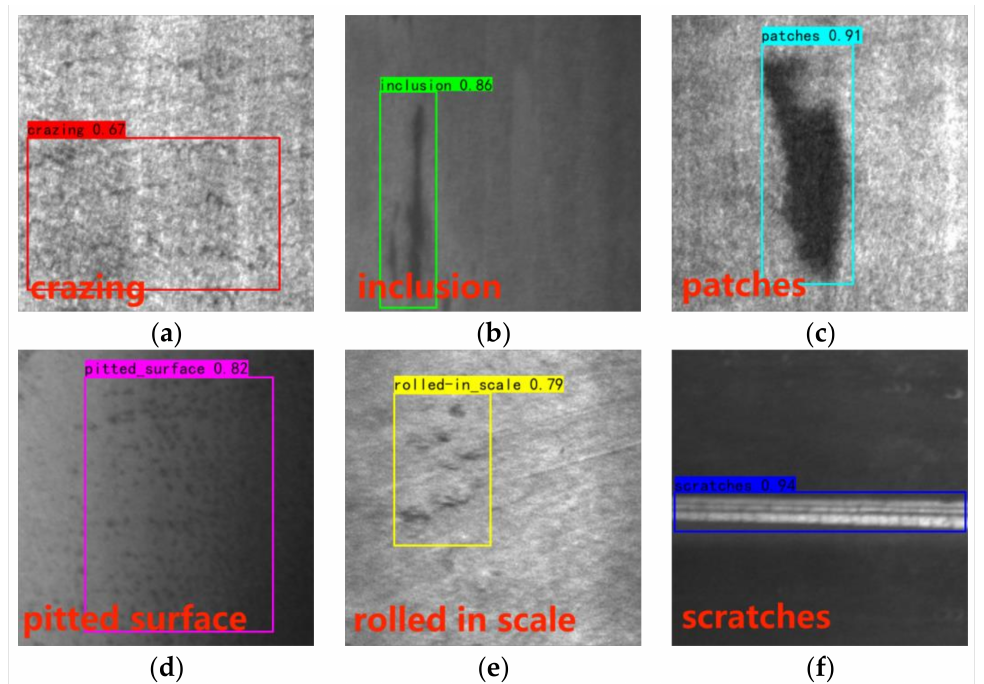
Figure 8. Results of steel surface defect detection. ( a ) Crazing, ( b ) inclusion, ( c ) patches, ( d ) pitted surface, ( e ) rolled in scale, ( f )